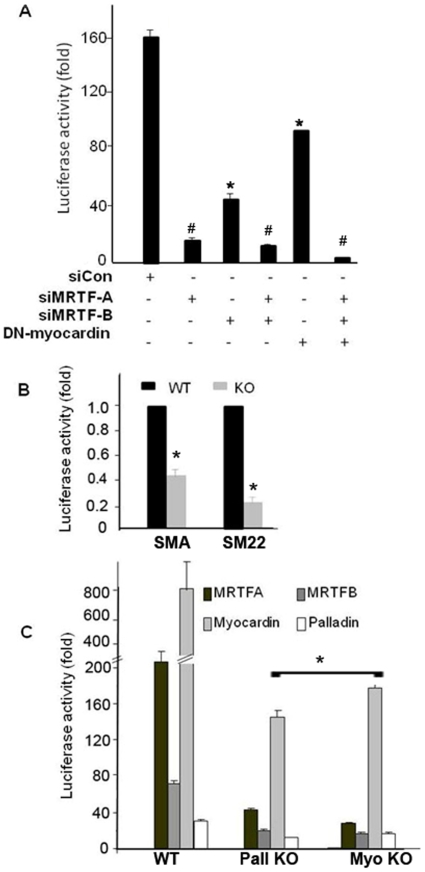
Palladin induces SMC marker gene transcription through the myocardin-MRTF-SRF pathway.A) down regulation of MRTFs and myocardin attenuates palladin induced SMA activity in A404 cells. siRNA to MRTFs (siMRTF-A and siMRTF-B) and dominant negative myocardin (DN Myo) constructs were cotransfected with SMA promoter luciferase constructs alone or with a palladin expressing plasmid into A404 cells, and luciferase activities were measured. Values represent the mean±SEM (n = 3). *, p<0.05; # p<0.01. B) SMA and SM22 promotor transcriptional activities were decreased in palladin null APSCs. Wild type and palladin null APSCs were transfected with SMA and SM22 luciferase constructs. Luciferase assays were performed 36 h after transfection. Values represent the mean±SEM (n = 3). *, p<0.05. C) palladin, myocardin and MRTFs interdependently regulate SMC marker genes. SMA promoter luciferase construct was cotransfected with MRTF-A, -B, Myocardin, or palladin expressing plasmids into wild type, palladin null, and myocardin null APSCs. Luciferase activities were measured. Values represent mean ±SEM of three independent experiments. *, p<0.05 compared to WT.